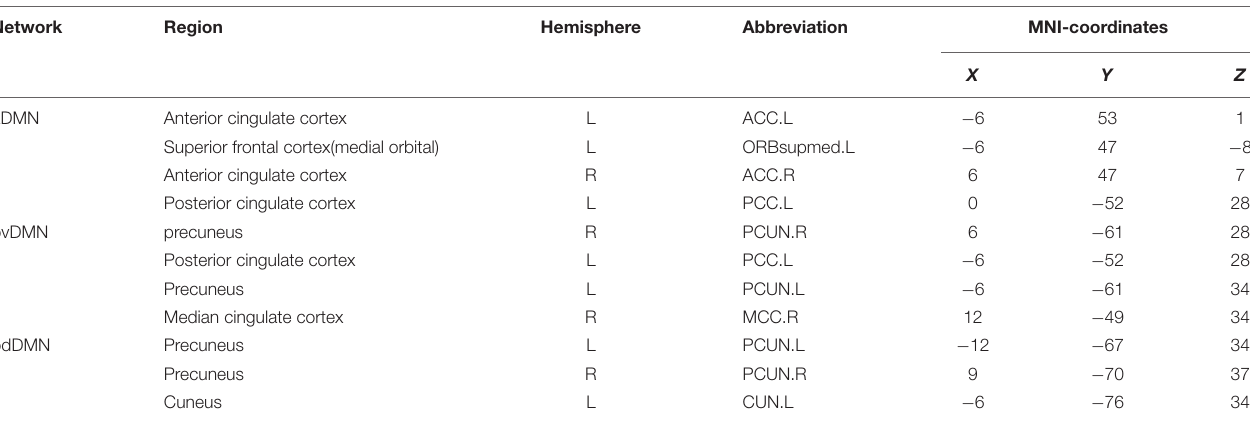
TABLE 2 | Regions of interest (ROIs) in DMN. Network